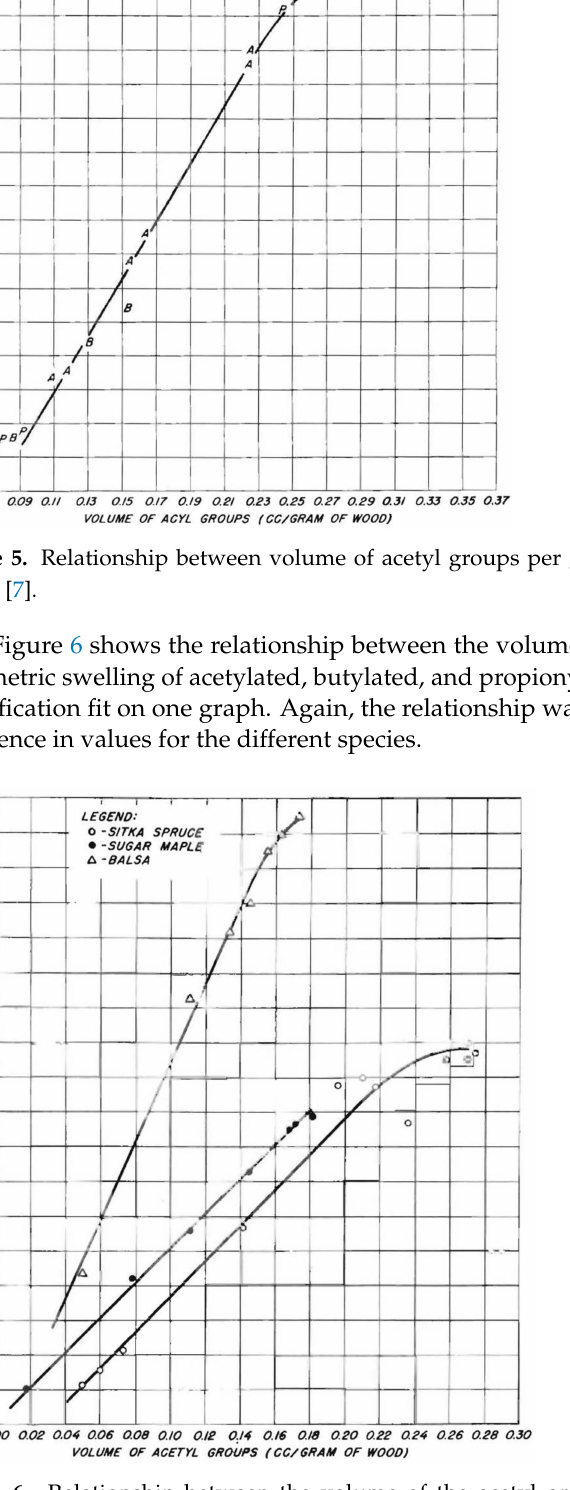
Figure 6. Relationship between the volume of the acetyl groups and the external volumetric swelling